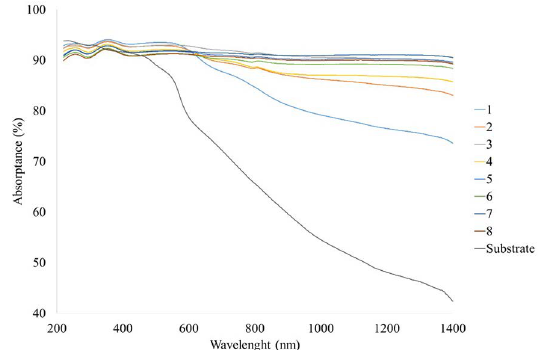
Figure 1. Percentage of absortance of the electrodeposited black chromium